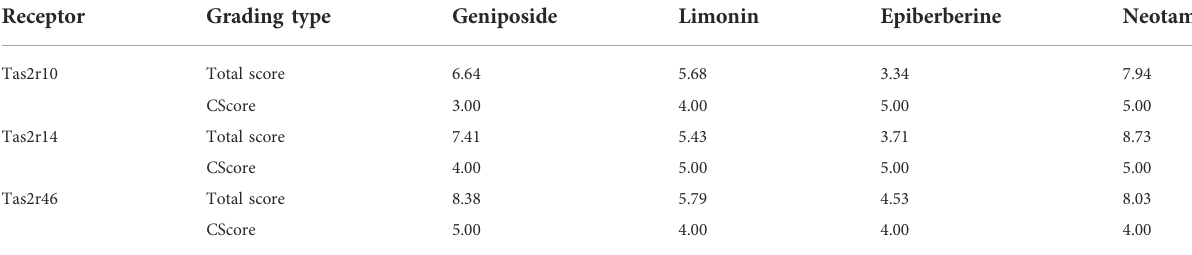
TABLE 7 Docking results of bitter receptors and